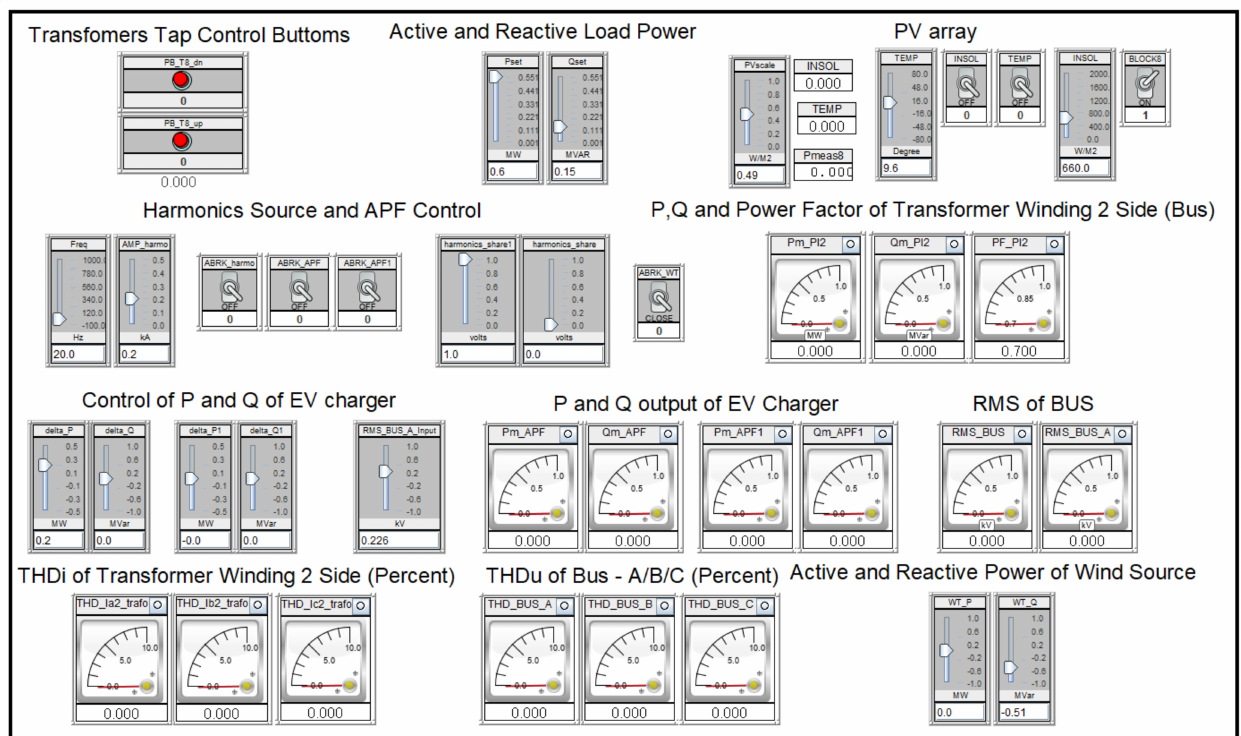
Figure 17. RSCAD runtime